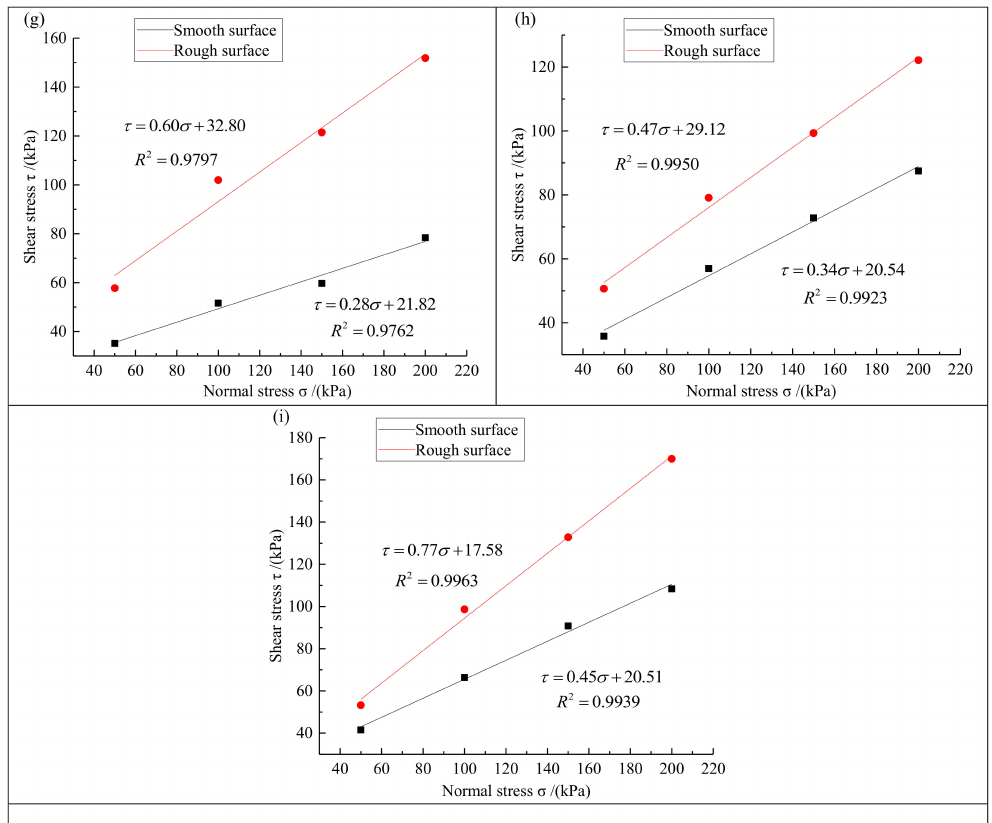
Figure 5. Maximum shear stress–normal stress curve of contact surface between the smooth (black) and rough (red) geomembranes and di ff erent solid wastes or soil samples. ( a ) desulfurized gypsum; ( b ) fly ash; ( c ) red mud; ( d ) mercury slag; ( e ) lead-zinc slag; ( f ) manganese slag; ( g ) silica fume; ( h ) clay; ( i )